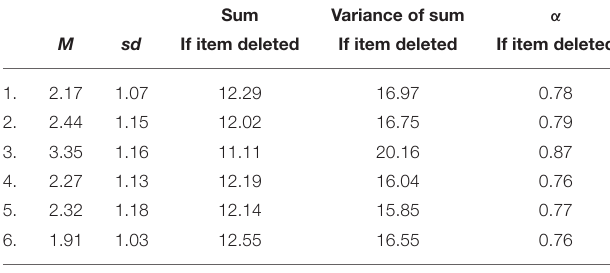
TABLE 1 | Adaptation difficulties in returning to routine following COVID-19